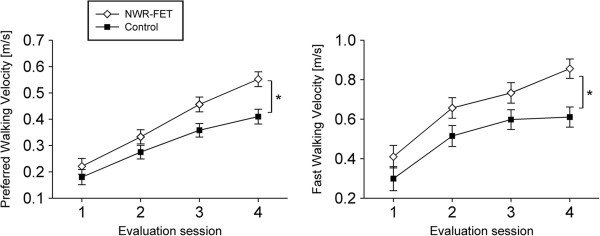
Walking velocity. Preferred and fast walking velocities at inclusion (evaluation 1), immediately after completion of training (evaluation 2), 1 month (evaluation 3), and 6 months (evaluation 4) after completion of training. Asterisk indicates a statistically significant difference between groups after finishing treatment (p < 0.001).